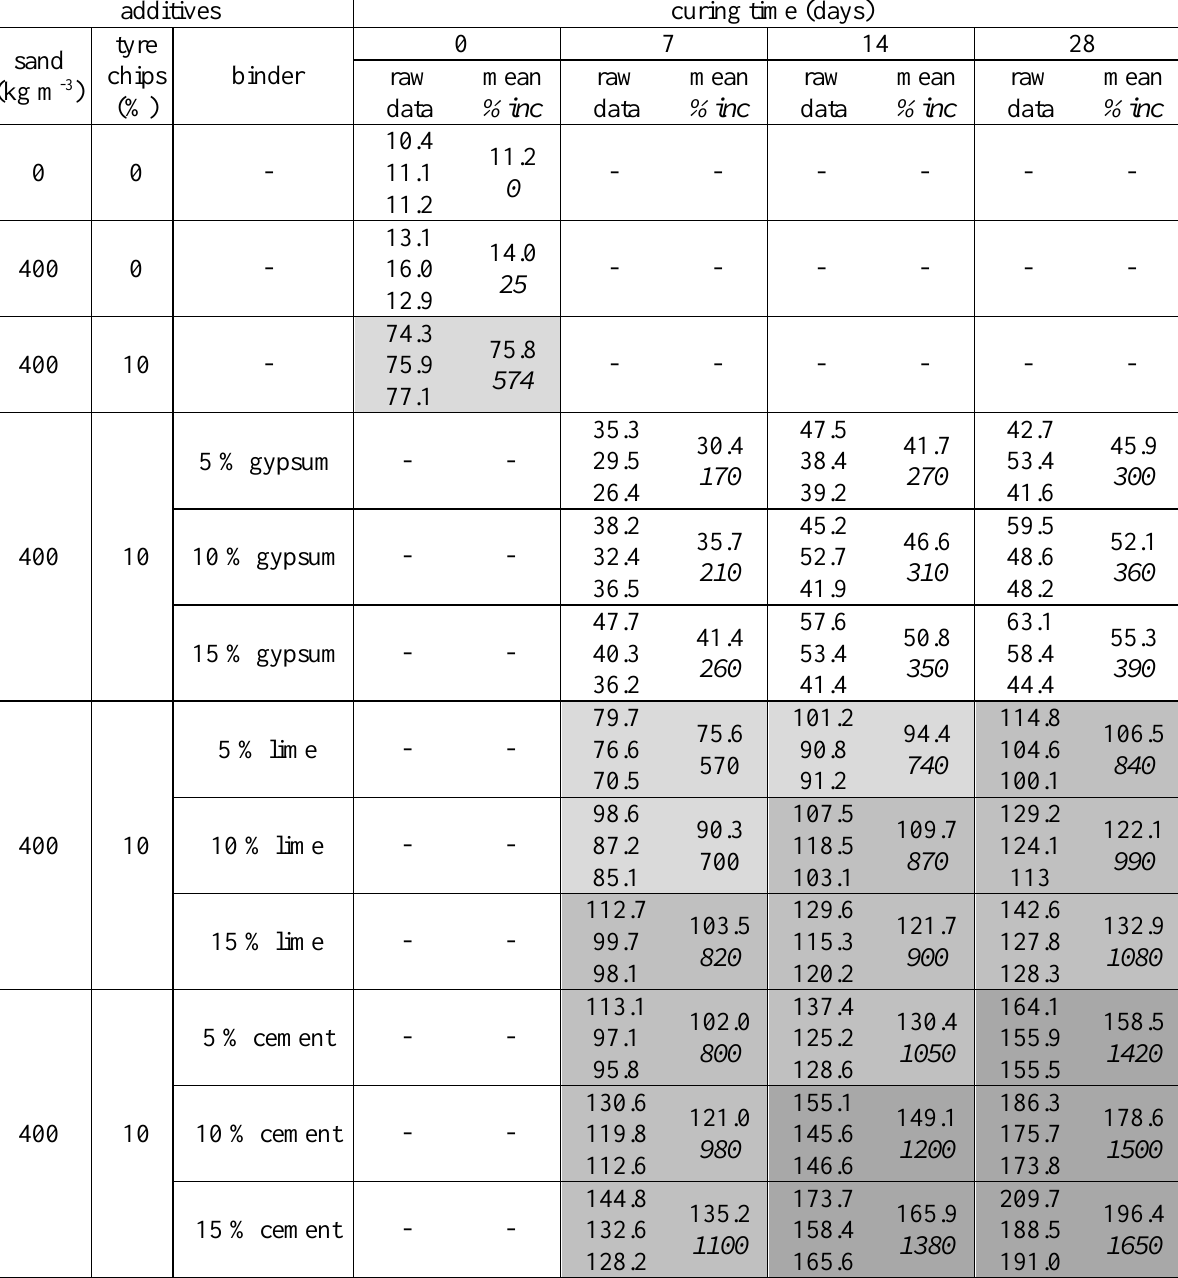
Table A2. Cohesion (c, kPa) of Chaghakhor peat with different combinations of additives and curing times (from direct shear test). For each combination, the test results for the three replicate specimens (raw data) are shown on the left, and the mean cohesion value on the right. Beneath each mean value, the figure in italics ( %inc ) is the percentage increase in the parameter compared with untreated peat (top row). The data for specimens without supplements (top three rows) are taken from Rahgozar & Saberian (2016). The results of all 81 of the direct shear tests carried out during this study are shown in the bottom nine rows of the Table. Shading indicates the improvement in cohesion achieved: no shading indicates an improvement of ≤ 500